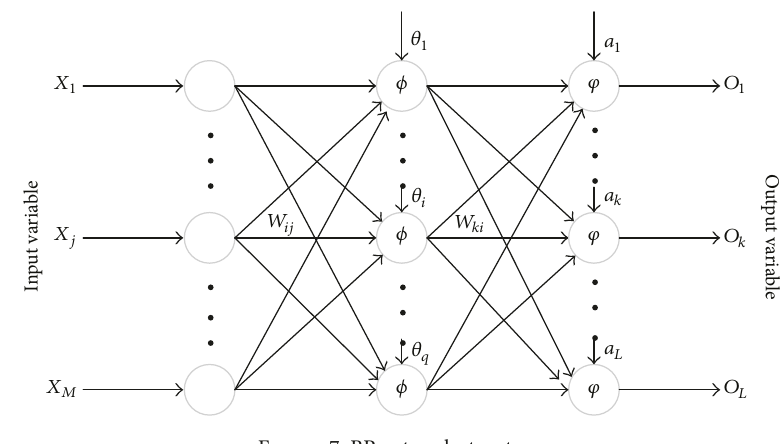
Figure 7: BP network structure.